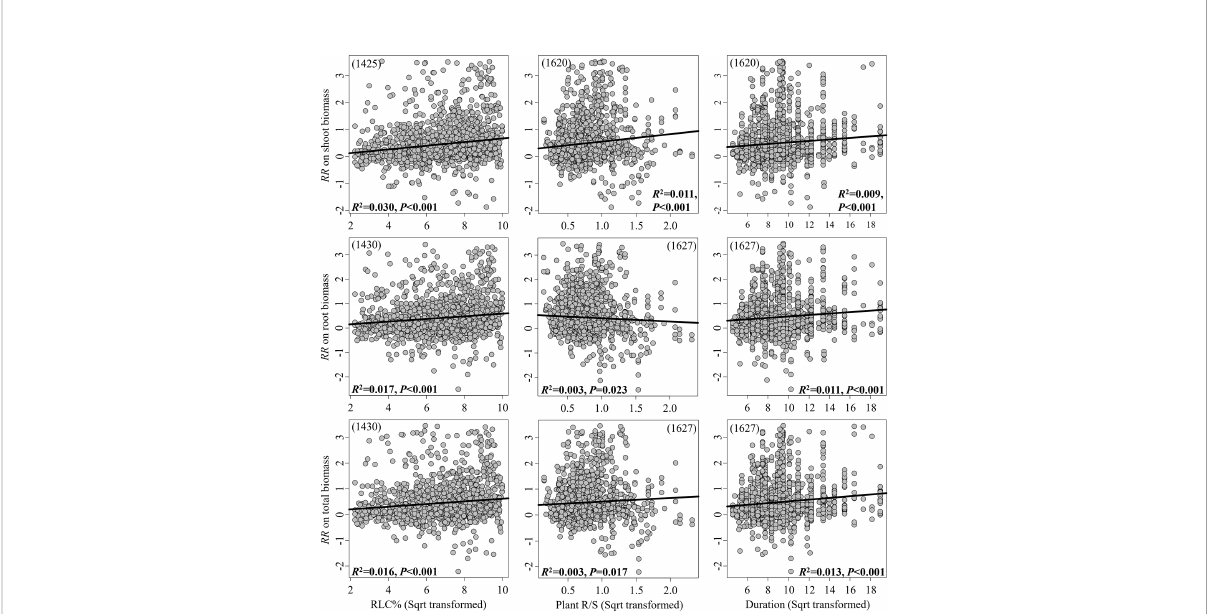
FIGURE 2 Linear relationships between the effect size of arbuscular mycorrhizal fungi (AMF) on plant biomass (shoot, root, and total) and the AMF root length colonization (RLC), plant root-to-shoot ratio (R/S), and experimental duration. The signi fi cance test for the linear relationship was based on a random effects model with a residual maximum likelihood (REML) method. P -values ≤ 0.05 were considered signi fi cant. Values in parentheses are the number of observations included in the analysis.